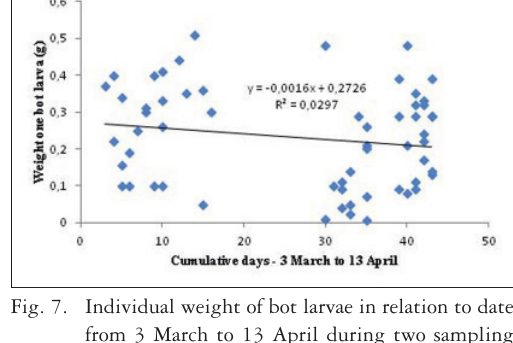
Fig. 7. Individual weight of bot larvae in relation to date from 3 March to 13 April during two sampling years (2008, 2009). Regression slope was not sig- nificant ( P =